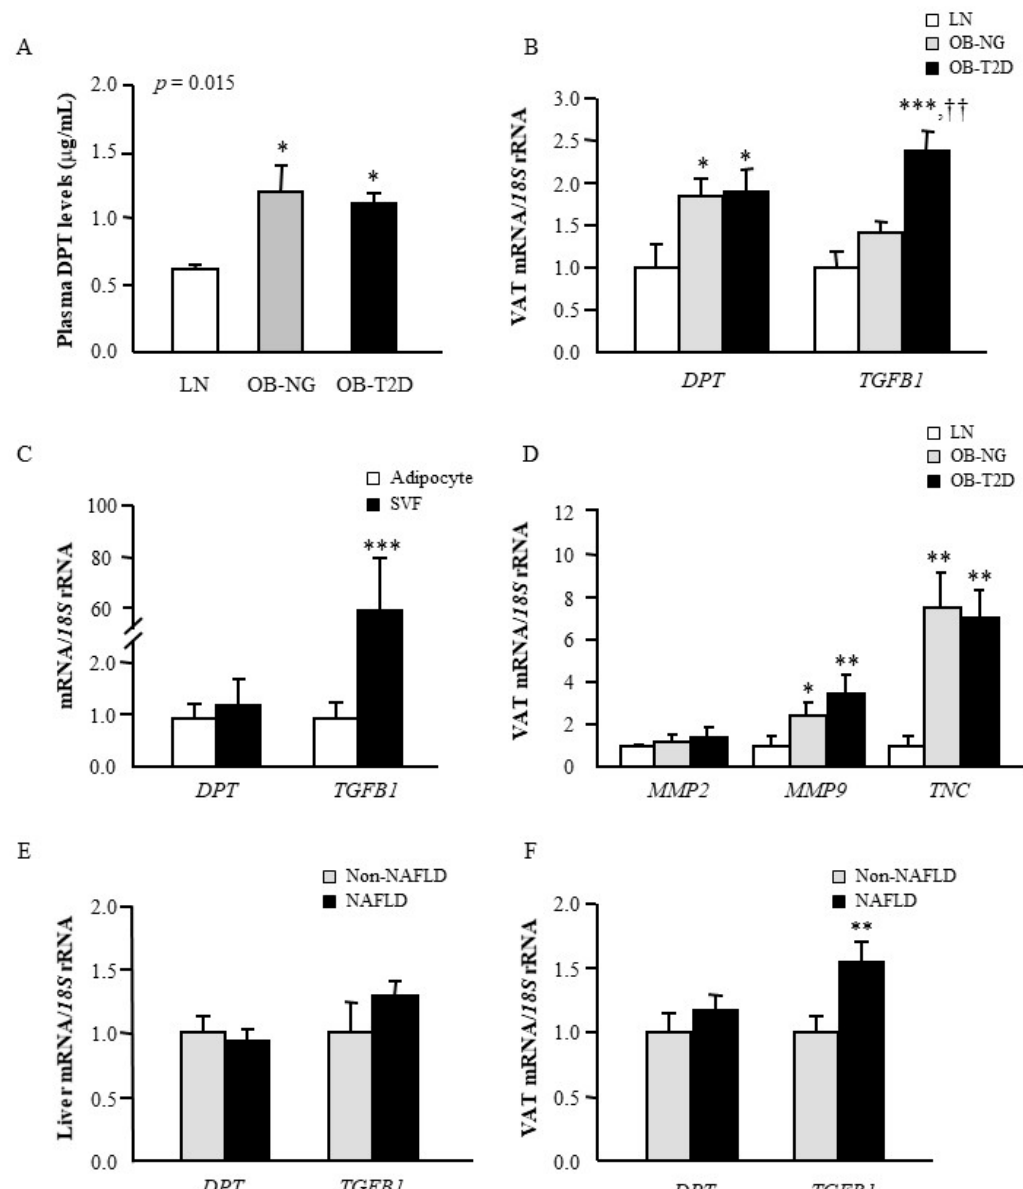
Figure 1. Circulating concentrations and gene expression levels of dermatopontin (DPT) in obesity, obesity-associated type 2 diabetes (T2D) and non-alcoholic fatty liver disease (NAFLD). ( A ) Fasting plasma concentrations of DPT in lean (LN) volunteers, obese normoglycemic (NG) subjects and obese patients with T2D. ( B ) Bar graphs show the mRNA levels of DPT and tumour growth factor- β ( TGFB1 ) in visceral adipose tissue (VAT) from lean volunteers, obese NG subjects and obese patients with T2D as well as in ( C ) adipocytes and stromovascular fraction (SVF) cells. ( D ) Bar graphs show the mRNA levels of metalloproteinase ( MMP )-2, MMP9 and tenascin C ( TNC ) in VAT from lean volunteers, obese NG subjects and obese patients with T2D Gene expression levels of DPT and TGFB1 in liver ( E ) and VAT ( F ) from obese volunteers classified according to the presence or not of NAFLD. Bars represent the mean ± SEM. Di ff erences between groups were analysed by one-way ANOVA followed by Tukey’s tests as well as by paired or unpaired two-tailed Student’s t tests, where appropriate. * p < 0.05, ** p < 0.01 and *** p < 0.001 vs. LN subjects, adipocytes or nonNAFLD. †† p < 0.01 vs. obese NG